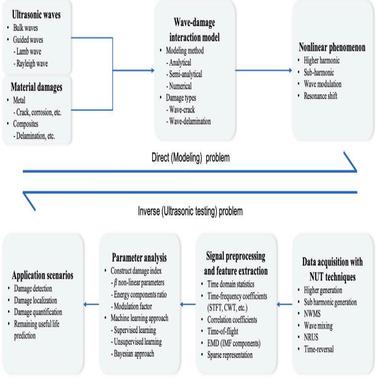
Flowchart of the direct and inverse problem for damage characterization using NUT.